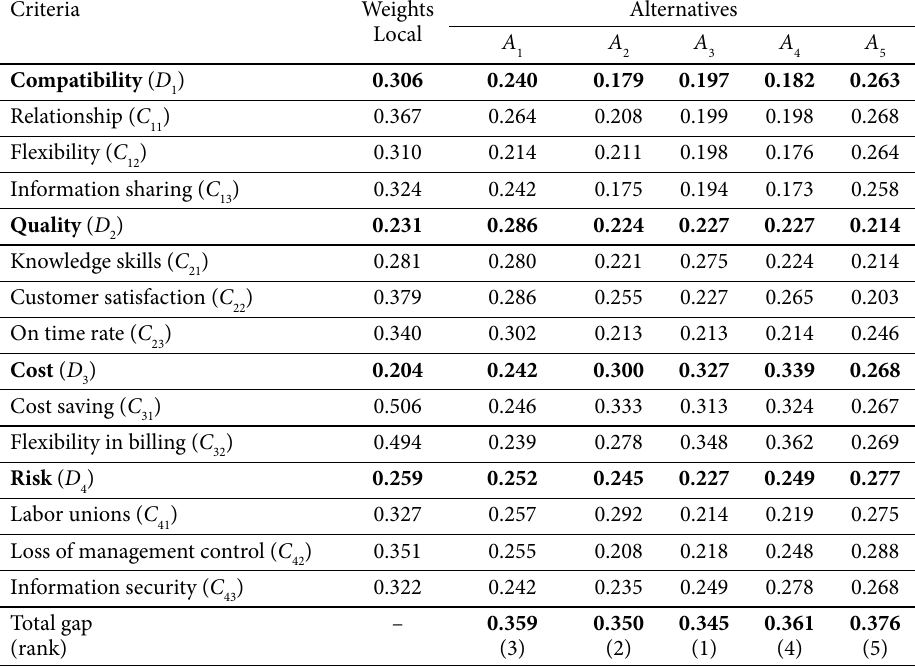
Table 6. Gap ratio values of potential suppliers by Fuzzy Integral